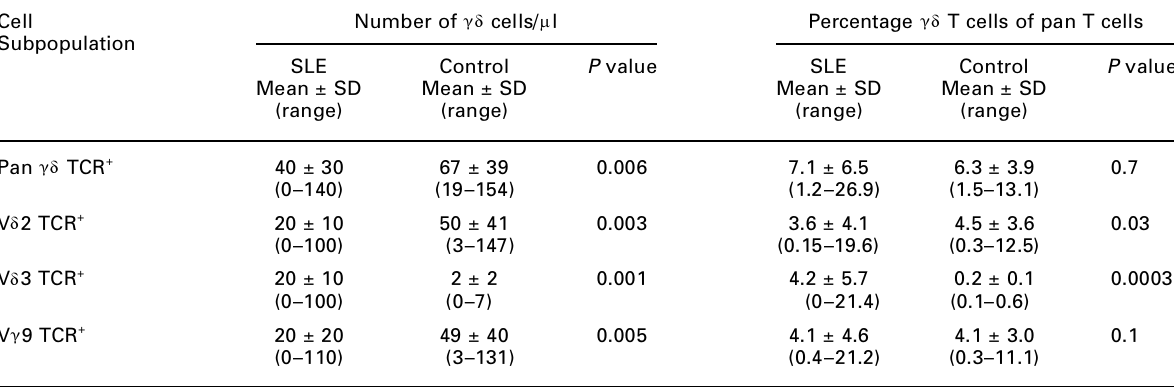
Table 3. Analysis of g d TCR expression on circulating T cells of SLE patients and healthy donors (mean of cells number/ m l ± SD and range in parentheses) Cell Subpopulation